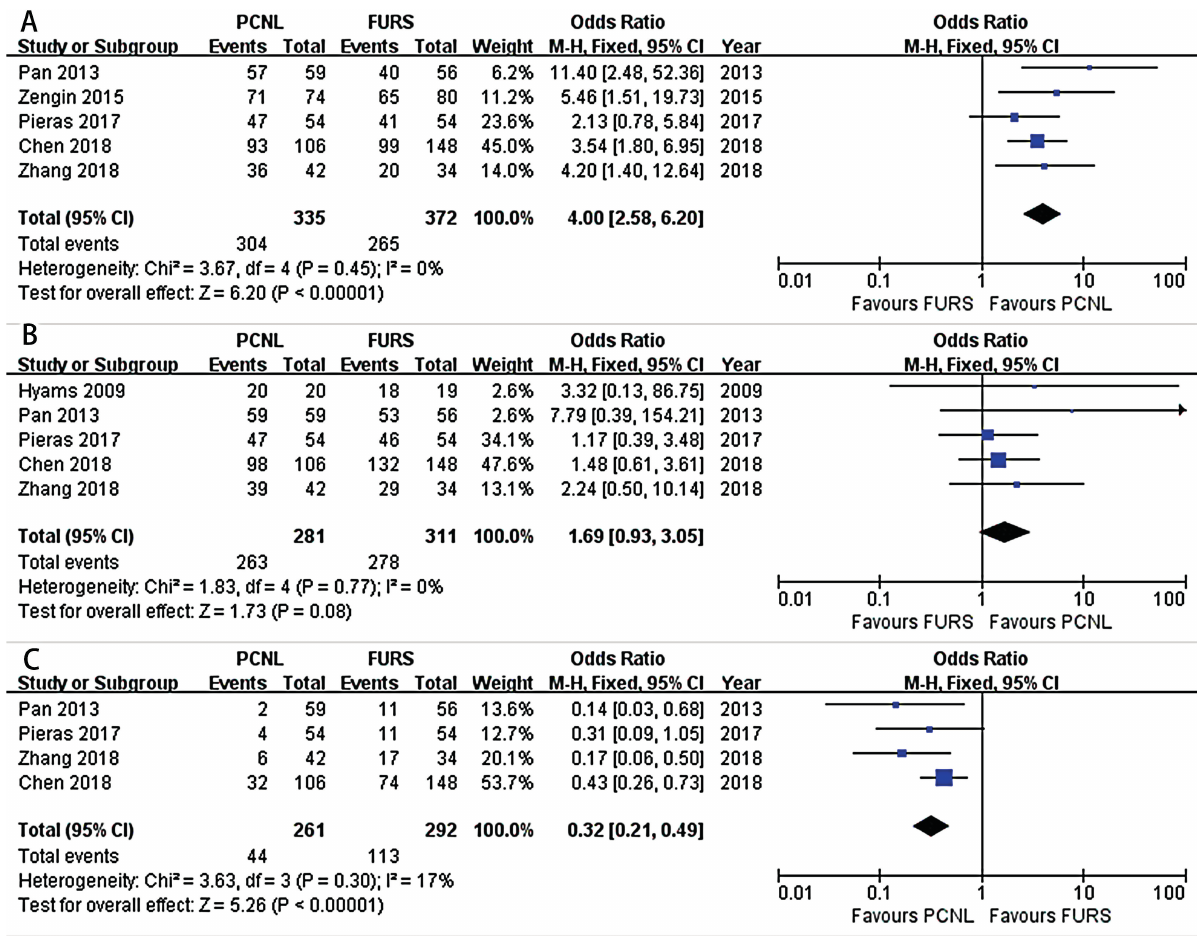
Figure 2 - Forest plots illustrating meta-analysis of (A) initial SFR; (B) final SFR; and (c) multiple